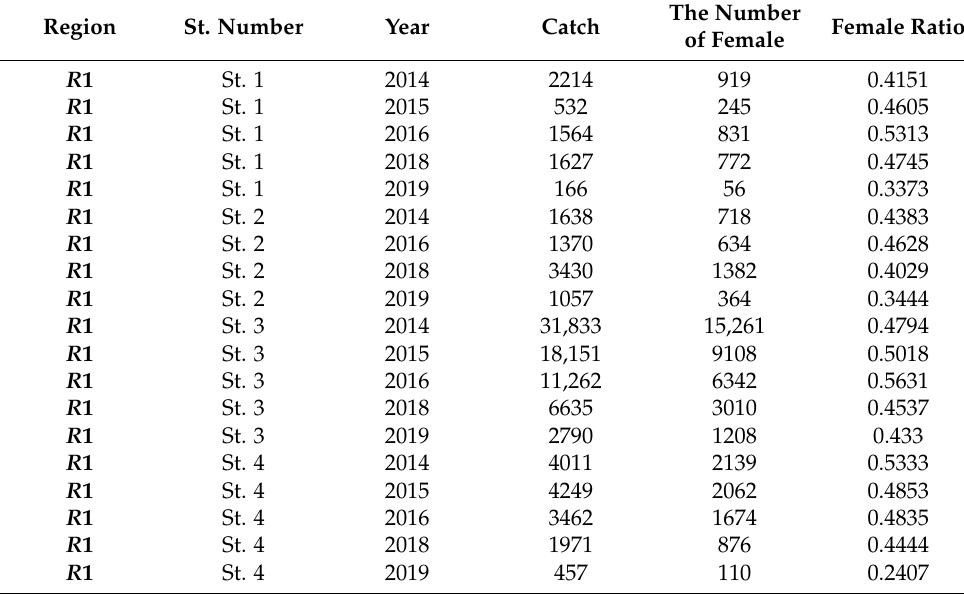
Table A1. The catch of chum salmon ( Oncorhynchus keta ) individuals and the number of females (female ratio) in the R 1 region.